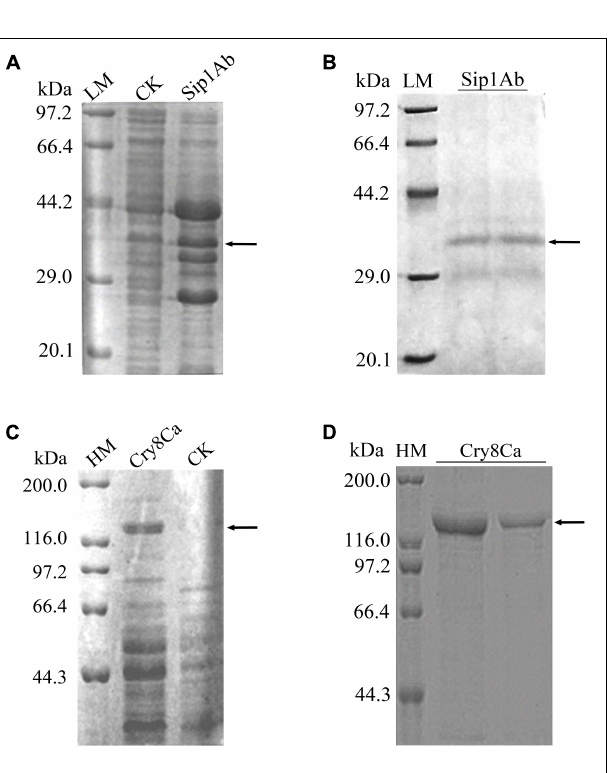
FIGURE 2 | Expression and purification of Sip1Ab and Cry8Ca. LM: Protein Molecular Weight Marker (Low) (Takara Biomedical Technology Co., Ltd., Beijing, China), HM: Protein Molecular Weight Marker (High) (Takara Biomedical Technology Co., Ltd., Beijing, China), CK: whole protein of pET21b-BL21 (DE3). Samples were subjected to SDS-PAGE followed by Coomassie Blue staining. (A) Expression of soluble Sip1Ab in E. coli . (B) The purified Sip1Ab. (C) Expression of soluble Cry8Ca in E. coli . (D) The purified